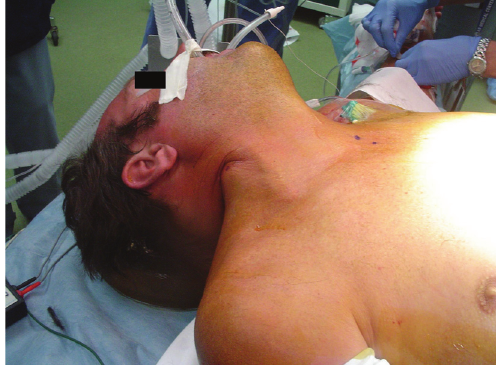
Figure 3: Photograph showing the object tenting the right side of the patient’s neck.